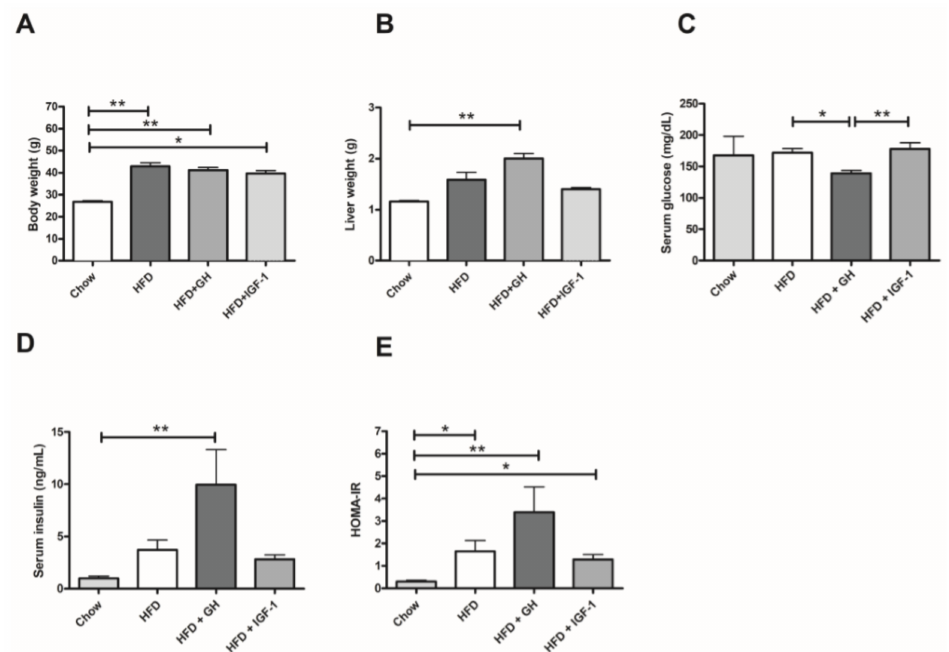
Figure 1. Metabolic effects of intervention according to study groups: ( A ) Body weight; ( B ) Liver weight; ( C ) Serum Glucose; ( D ) Serum Insulin and ( E ) Homeostasis Model Assessment of Insulin resistance (HOMA-IR). High fat diet (HFD) induced a significant increase in body weight and HOMA-IR. HFD induced hepatomegaly and a significant increase in serum insulin. * p < 0.05; ** p <